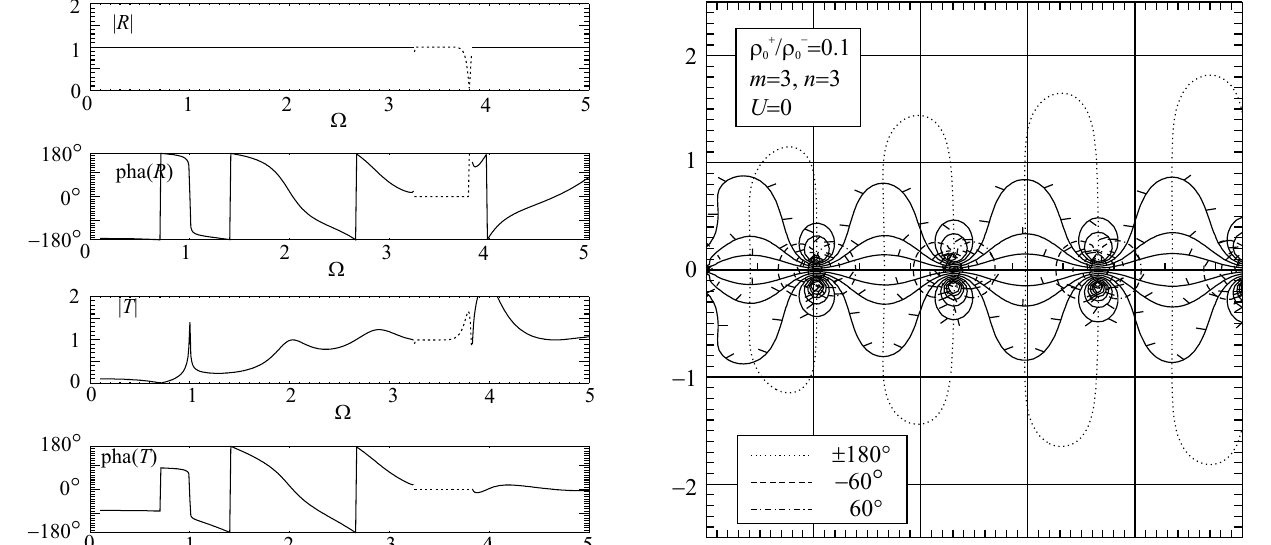
k y = 3 /aL 0 , V/V A, 0 = 5 .